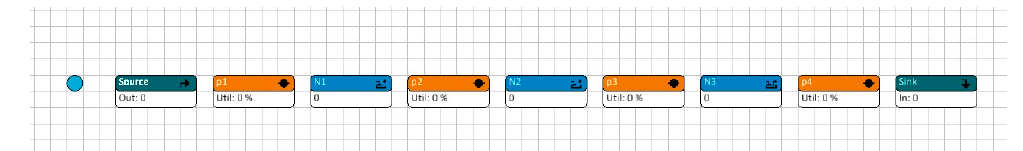
Figure 6. A simulation model with four machines and three buffers.